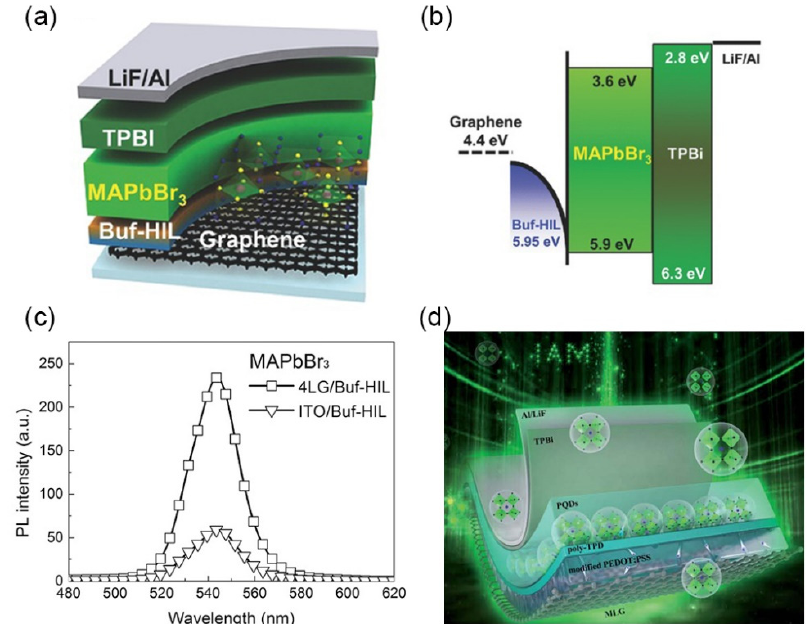
Figure 9. ( a ) Schematic structure and ( b ) energy level diagram of PeLEDs with a graphene anode, reprinted with permission from [64], Wiley, 2017; ( c ) PL spectra of MAPbBr 3 film on graphene / Buf-HIL and ITO / Buf-HIL, reprinted with permission from [64], Wiley, 2017; ( d ) Schematic structure of perovskite quantum dot LEDs with a graphene anode, reprinted with permission from [65], Royal Society of Chemistry, 2019.